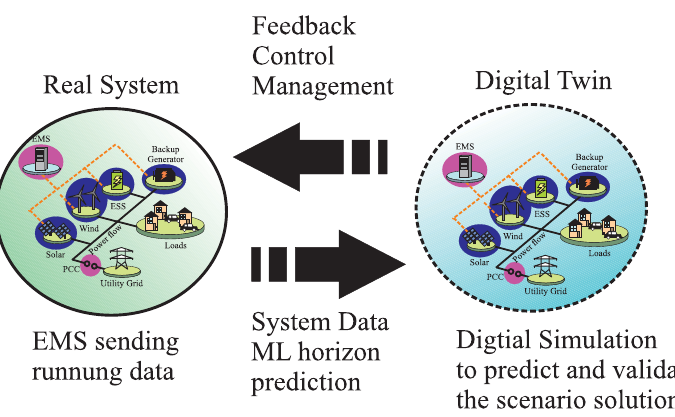
Figure 1. Digital twin microgrid